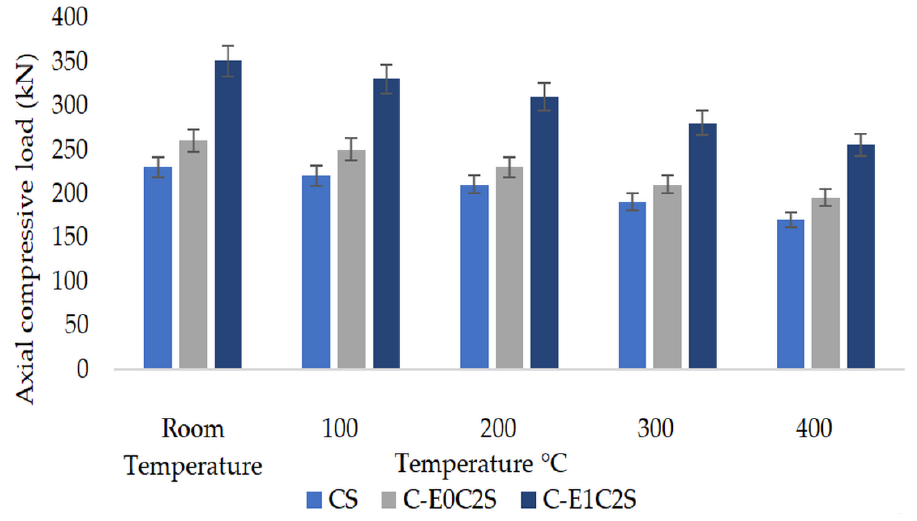
Figure 8. Maximum compressive load of unconfined and SFRP specimens exposed to elevated temperatures.